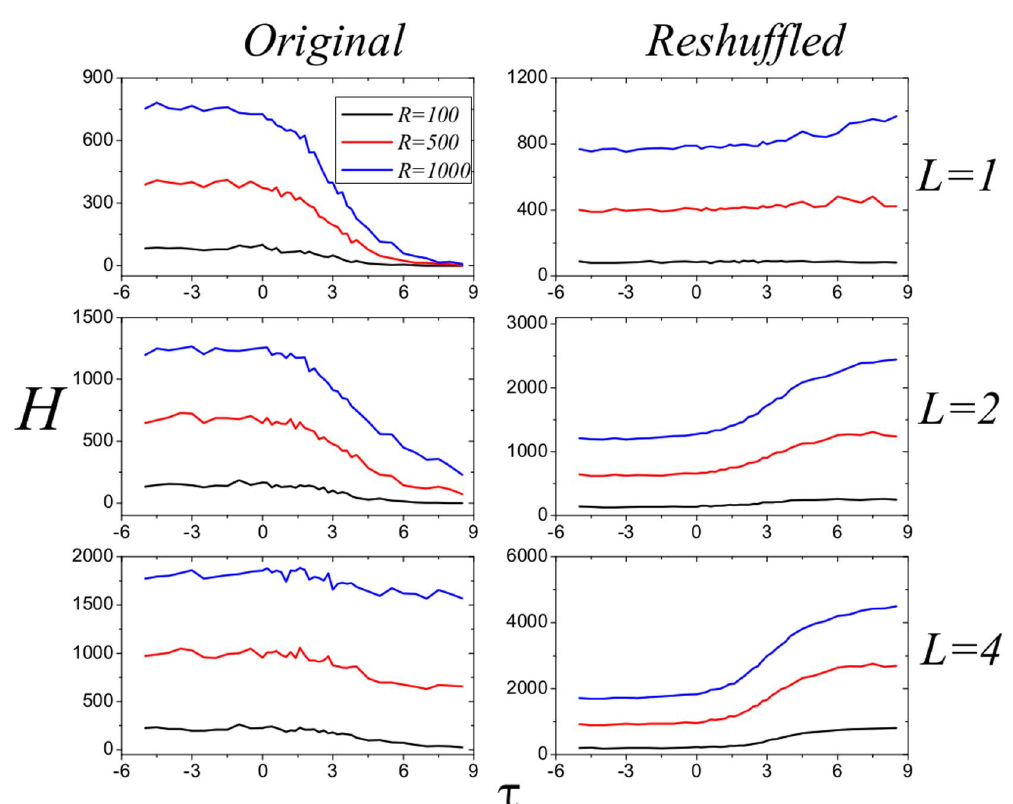
Figure 5. Performance of strategies with different t on original and reshuffled TM networks. The black, red and blue lines represent the results for the cases R ~ 100 , R ~ 500 and R ~ 1000 , respectively. Data points are obtained by averaging over 100 independent